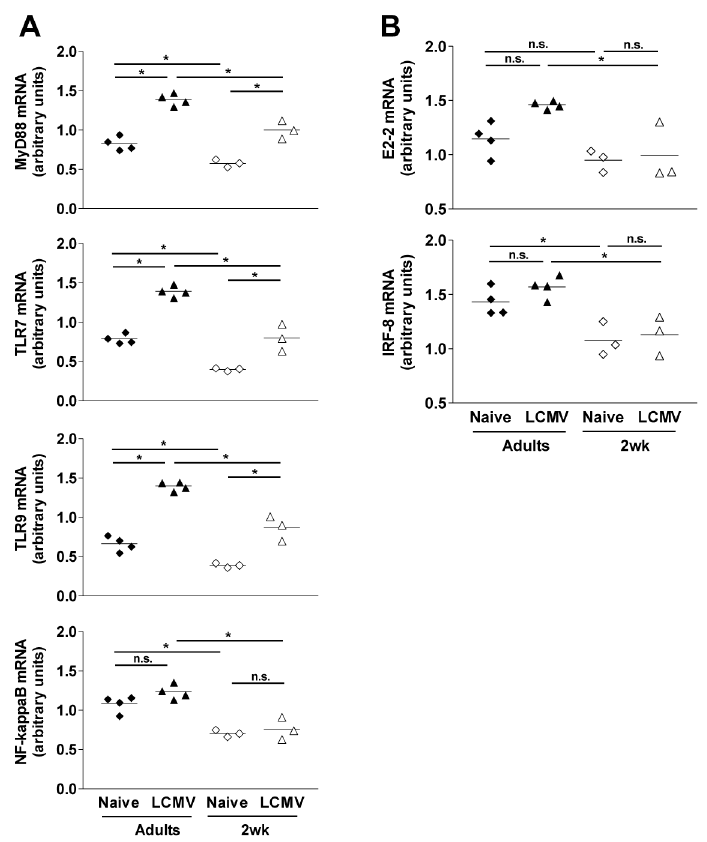
Figure 4. Downregulation of critical antiviral genes in infant pDCs. mRNA expression of MyD88, TLR7, TLR9 and NF-κB (A) or E2-2 and IRF-8 (B) in sorted pDCs from spleens of infant or adult mice before (naïve) and 1 day after LCMV infection (LCMV). *, p <0.05. n = 4 pools of 2 adult mice or 3 pools of 6 to 8 infant mice. One of two representative experiments is shown. doi: